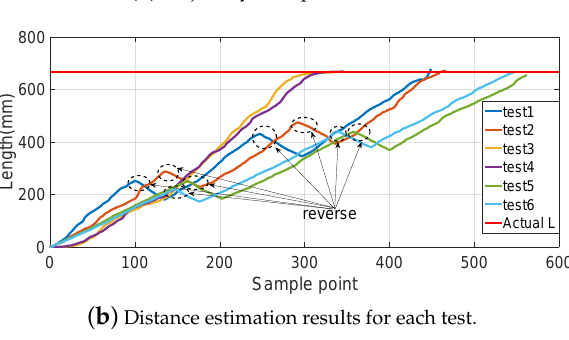
( b ) Distance estimation results for each test. Figure 12. Experiment of the GI tract.